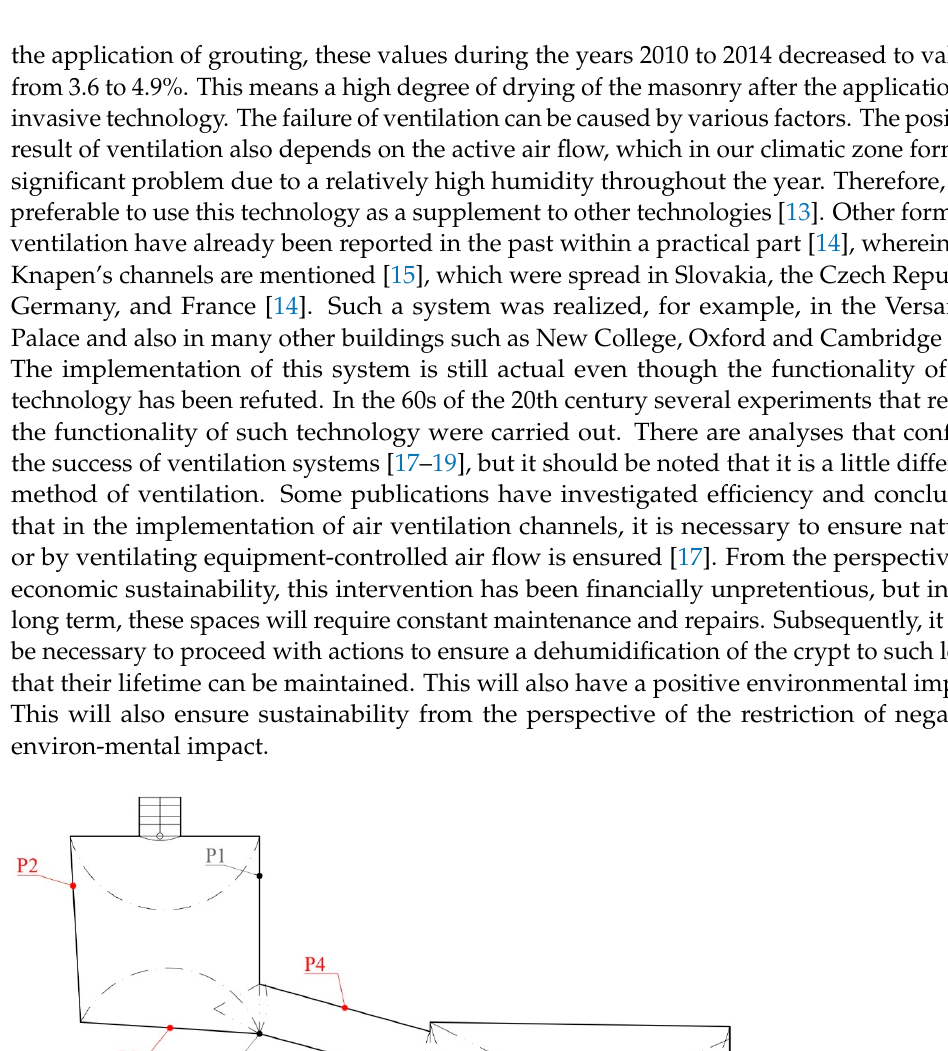
Table 3. Selected moisture values before and after remediation technology.